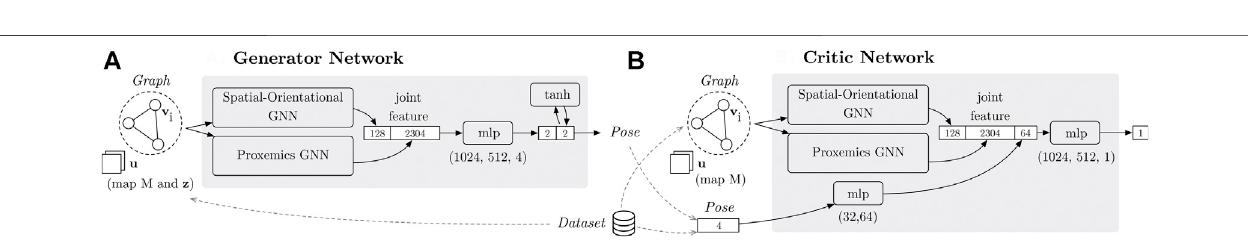
Frontiers in Robotics and AI |